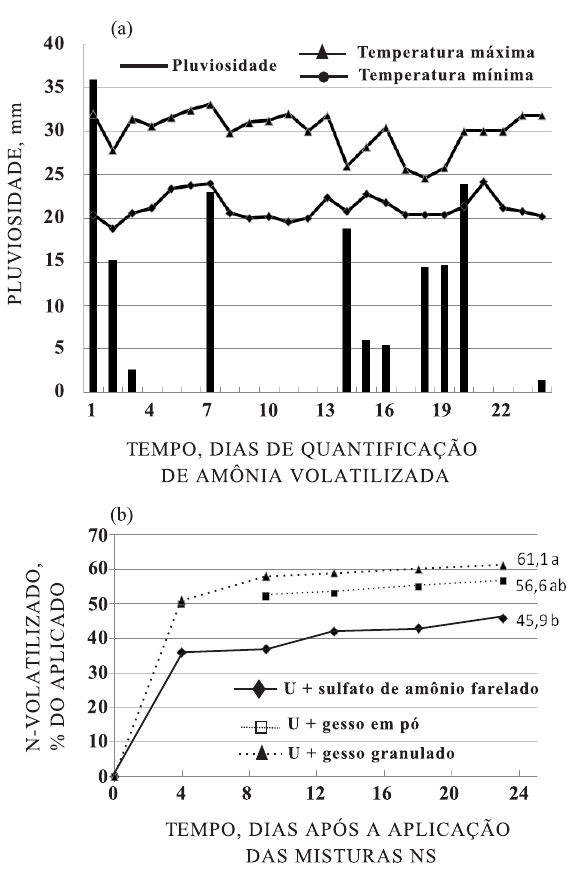
Figura 2. Distribuição da pluviosidade (a) no inter- valo de tempo transcorrido na quantificação de N-NH volatilizado (b) proveniente das mistu- 3 ras uréia+sulfato de amônio e uréia+gesso apli- cadas na primeira cobertura nitrogenada na cultura de milho, na safra 2005/2006, Votuporanga (SP). Entre as misturas, as médias seguidas de letras diferentes apresentam diferença signifi- cativa pelo teste de t (Student) a 5 %. DMS = 15,2; CV(%) =